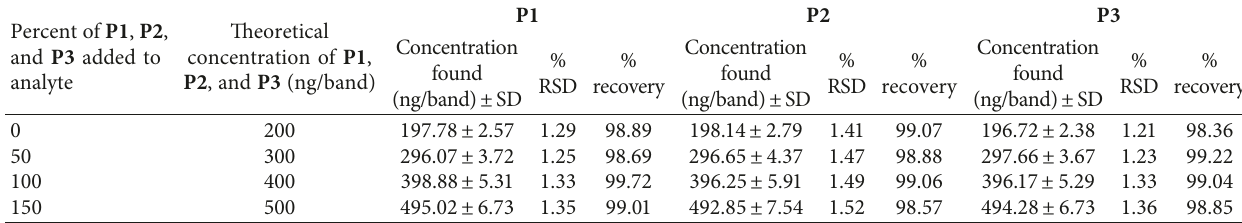
Table 6: Recovery as accuracy studies of the proposed HPTLC method ( n � 6).